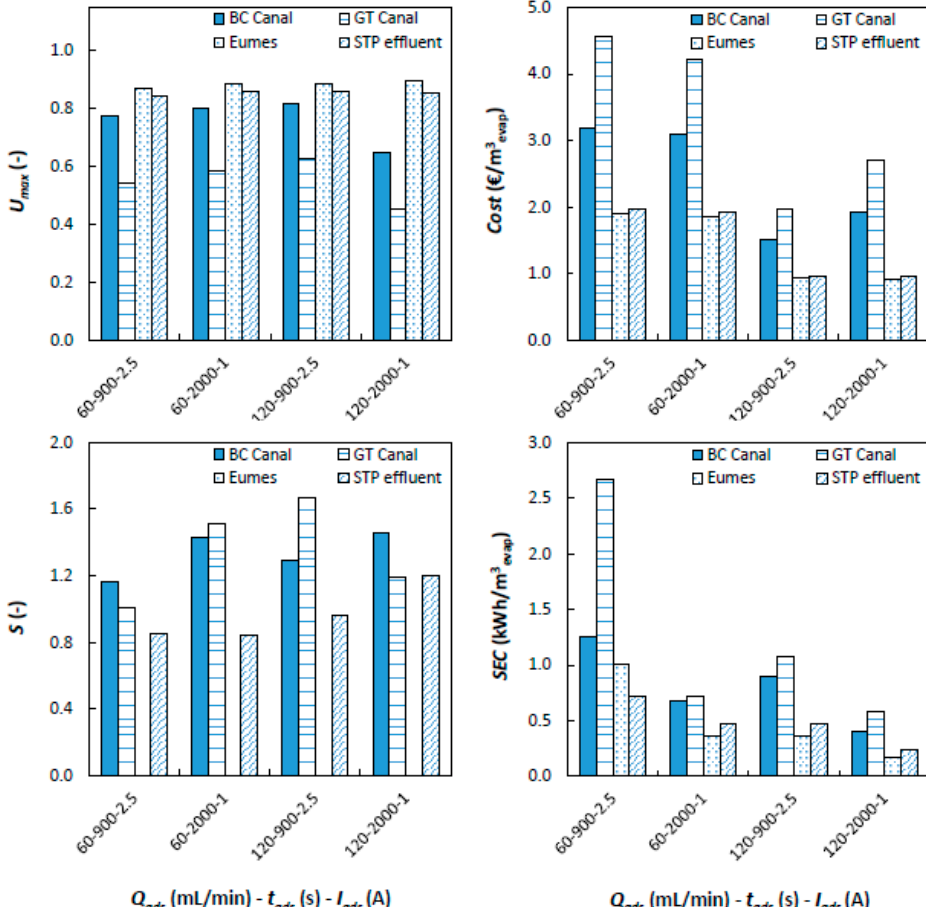
Figure 5. MCDI-CT process parameters SEC (kWh / m 3 evap ), U max (-), S (-) and Cost ( € / per m 3 evap ) derived from MCDI tests on 4 types of real cooling water.